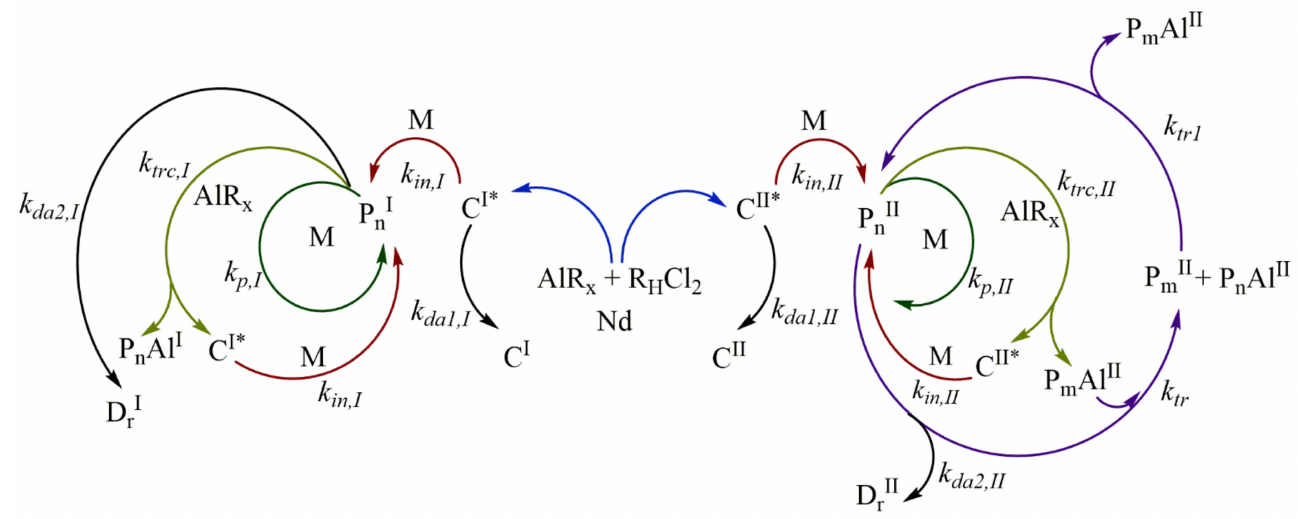
Figure 1. Proposed reaction mechanism for the myrcene polymerization by